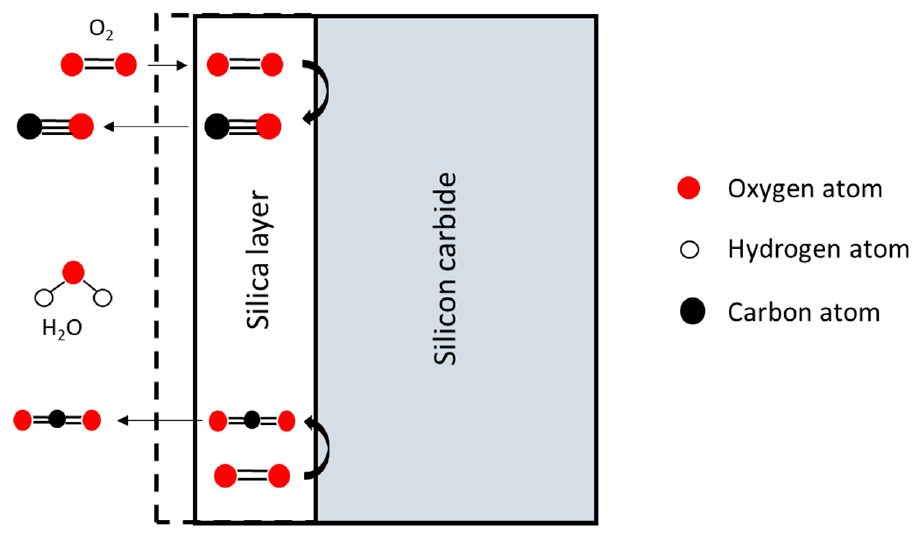
Figure 4. Scheme of the chemical reaction at the interface 5. Transport of product gases away from the surface.